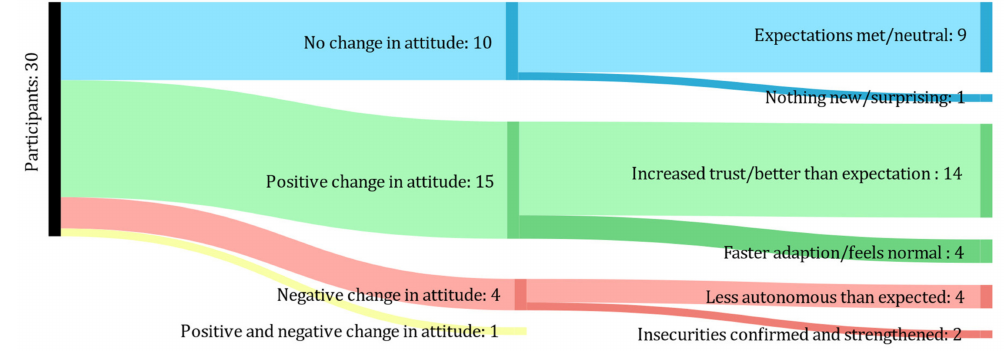
Figure 13. Frequencies of participants’ answers to interview question 5: “did your attitude towards the AS or automated vehicles generally change due to this experience? Why [not]? How?”.